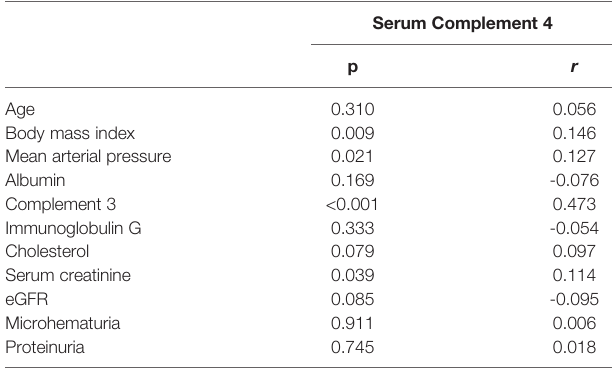
TABLE 3 | Correlations between serum C4 and clinical